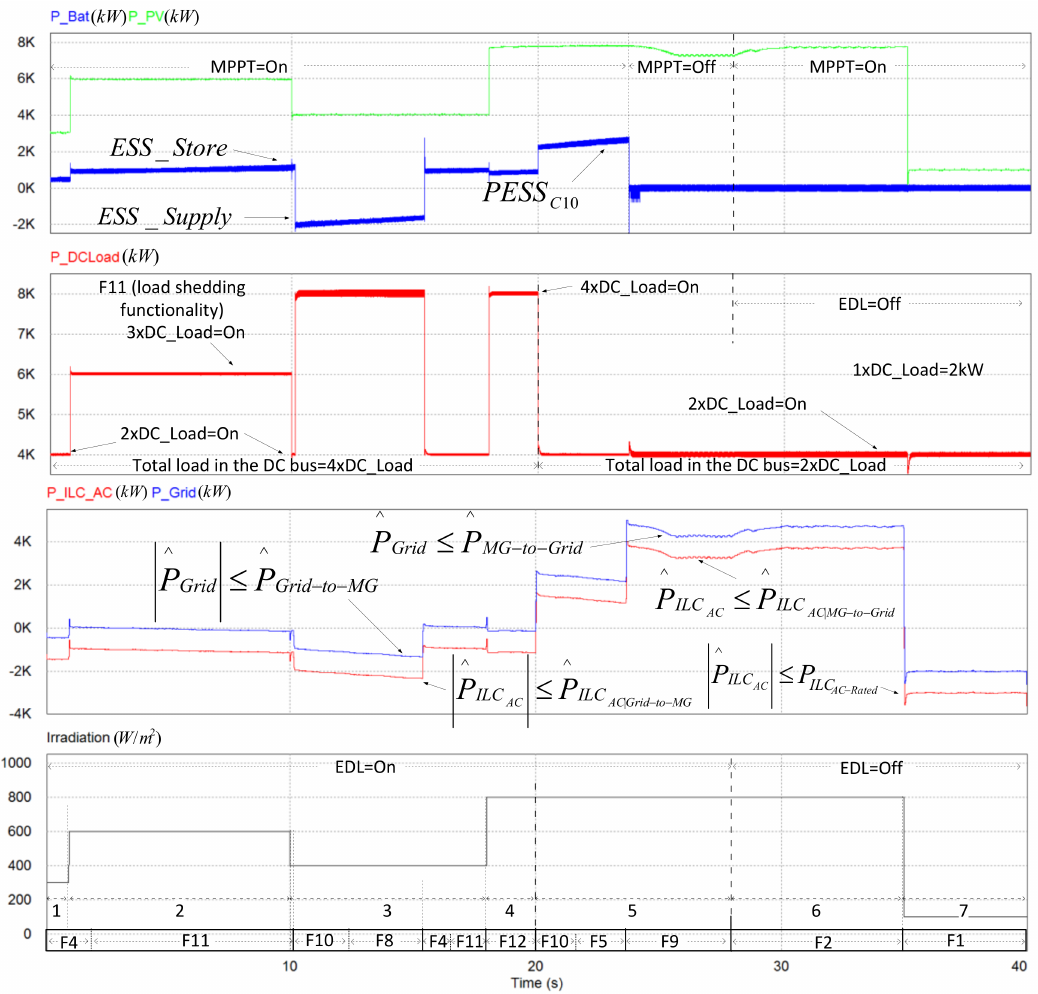
Figure 7. Simulation waveforms of the powers, P Bat , P PV , P DCLoad , P ILC_AC and P Grid .